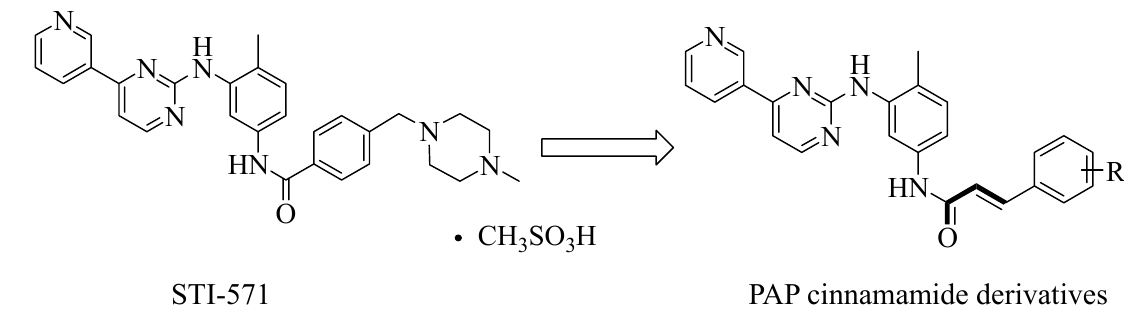
Figure 1. The structures of the designed compounds related to